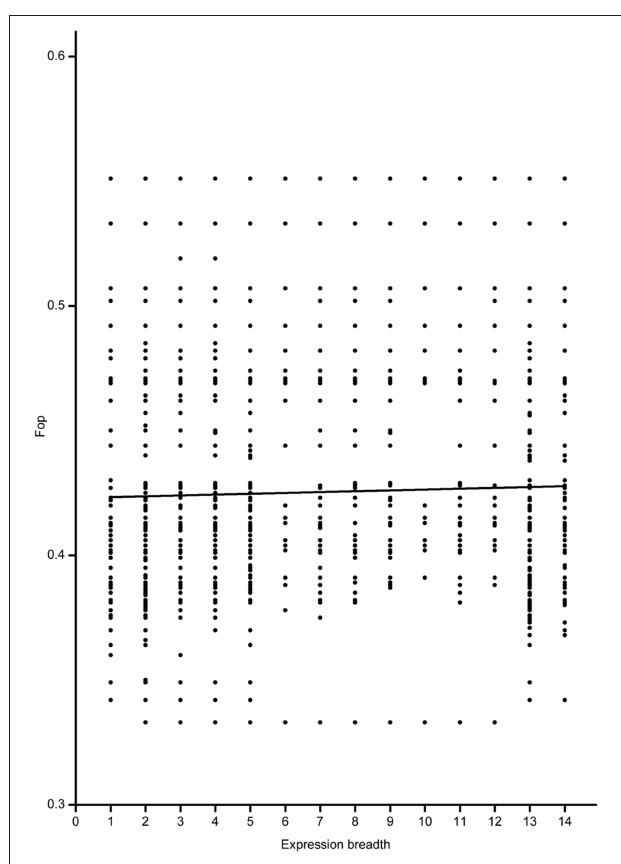
FIGURE 4 | Relationship between fop and expression breadth. The regression line: y = 0.000337875 X + 0.42302 . The number of 1–14 indicated yongg_leaf, flower, one.cm.pod, pod. shell. 10 DAF, pod. shell. 14 DAF, seed. 10 DAF, seed. 14 DAF, seed. 21 DAF, seed. 25 DAF, seed. 28 DAF, seed. 35 DAF, seed. 42 DAF, root, and nodule,